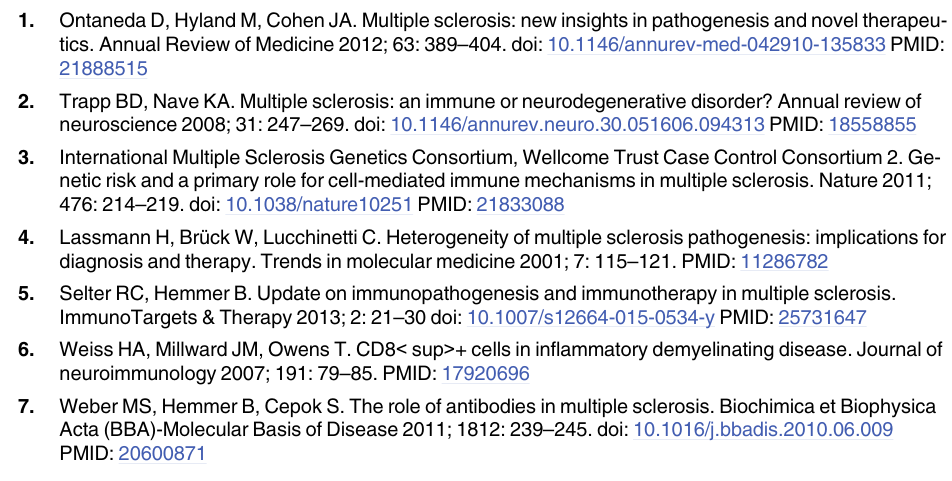
S1 Fig. Confirmation study for vitamin D Binding protein (VDBP). ELISA targeting the VDBP was performed for all patient and control samples included in the study (65 CIS, 72 RRMS, 42 PMS and 42 control samples). The results were correlated with the 2D-PAGE stud- ies. CSF level of VDBP protein was significantly differed in CIS and RRMS group, but not in PMS group.